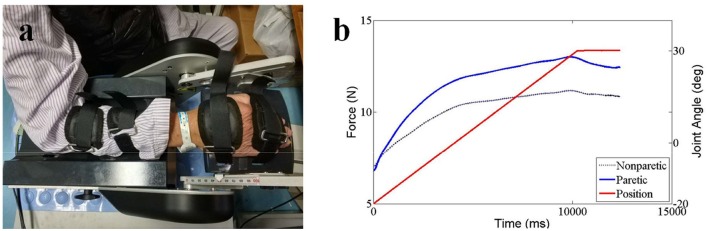
NeuroFlexor Method testing setup (a) and recording joint angle and resistance torque (b).